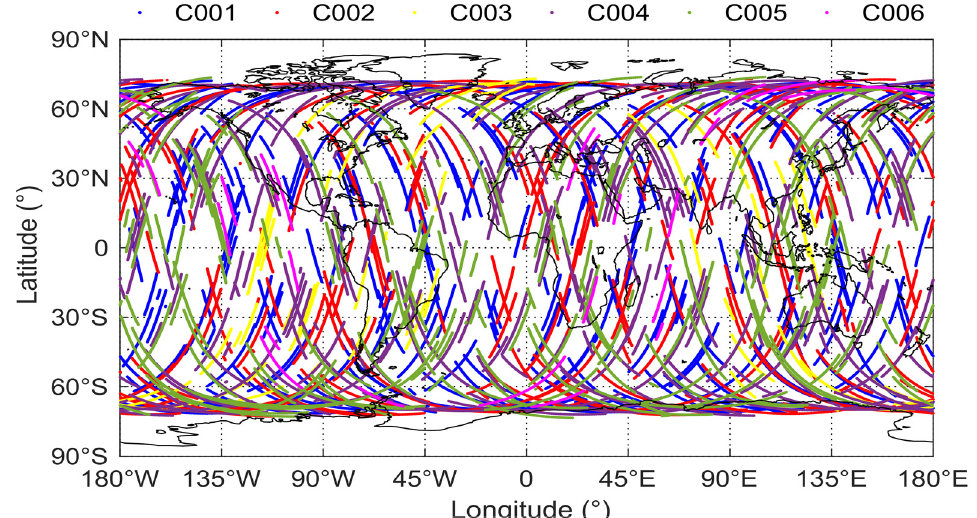
Figure 2. The distribution of COSMIC piercing points at the 1400 km thin shell on January 2, 2008